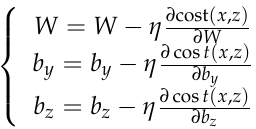
Figure 10. Overview of AE with a single hidden